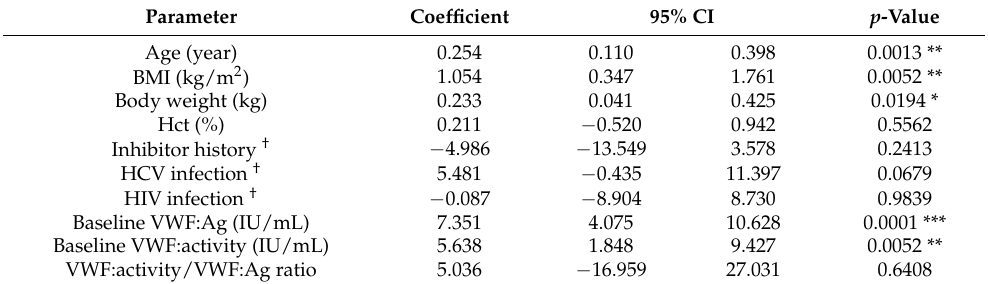
Figure 3. Correlation between the observed rFVIII-Fc half life and baseline VWF:Ag and baseline VWF:activity, respectively, in blood group non-O and blood group O patients of the development cohort. For non-O group PwHA (n = 26), baseline VWF:Ag had a moderate positive correlation to the observed rFVIII-Fc half life ( p -value < 0.001) and baseline VWF:activity had a strong positive correlation to the observed rFVIII-Fc half life ( p -value < 0.001). For O group PwHA (n = 20), both baseline VWF:Ag and baseline VWF:activity had a strong positive correlation to the observed rFVIII-Fc half life ( p -value < 0.001). The drawn lines show the best fit by univariate linear regression. Table 3. Univariate linear regression (UVLR) analysis of the half lives of non-O group patients, n = 26. Parameter Coefficient